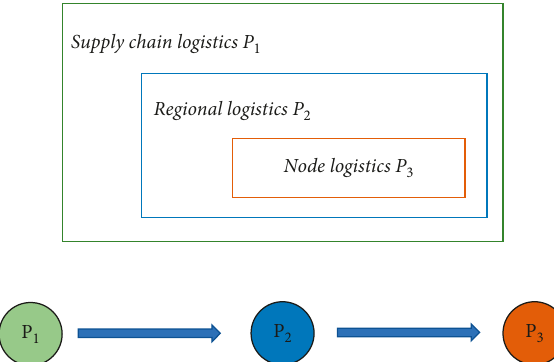
Figure 5: Profitability level of the multilevel logistics